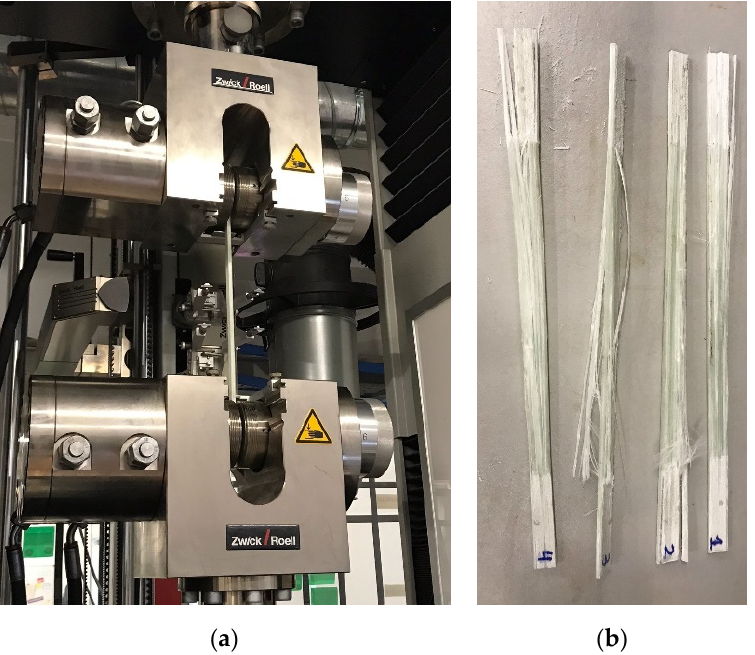
Figure 3. Beam testing scheme: ( a ) tensile test machine beam configuration; ( b ) beam test pieces with optical embedded fibre tested to failure on the machine.